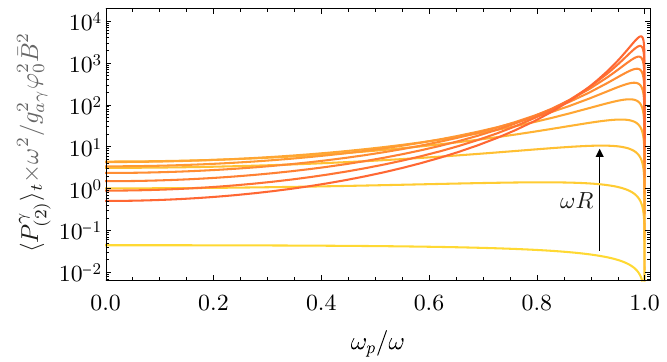
Figure 11 . The dependence of the time averaged power radiated by the axion star as a function of the plasma frequency ω and radius R of the star. Note the “resonant conversion” when ω p p → ω (the soliton frequency), and the strong dependence on the radius of the star. The plot should be understood under the assumption that the plasma frequency is constant within the radius of the star. In the above plot, ωR varies between 1 and 10 , with the peak scaling as ( ωR ) 6 . Also note that while the power increases with radius for ω , it decreases with radius when ω for p ≈ ω p (cid:28) ω large